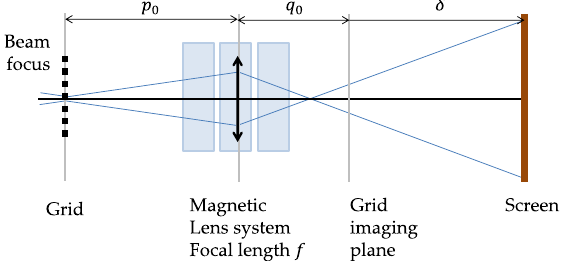
FIG. 7. Schematic of the grid-lens configuration. Distances p 0 and q 0 satisfy the imaging condition 1 =p 0 þ 1 =q 0 ¼ 1 =f for a lens of focal length f